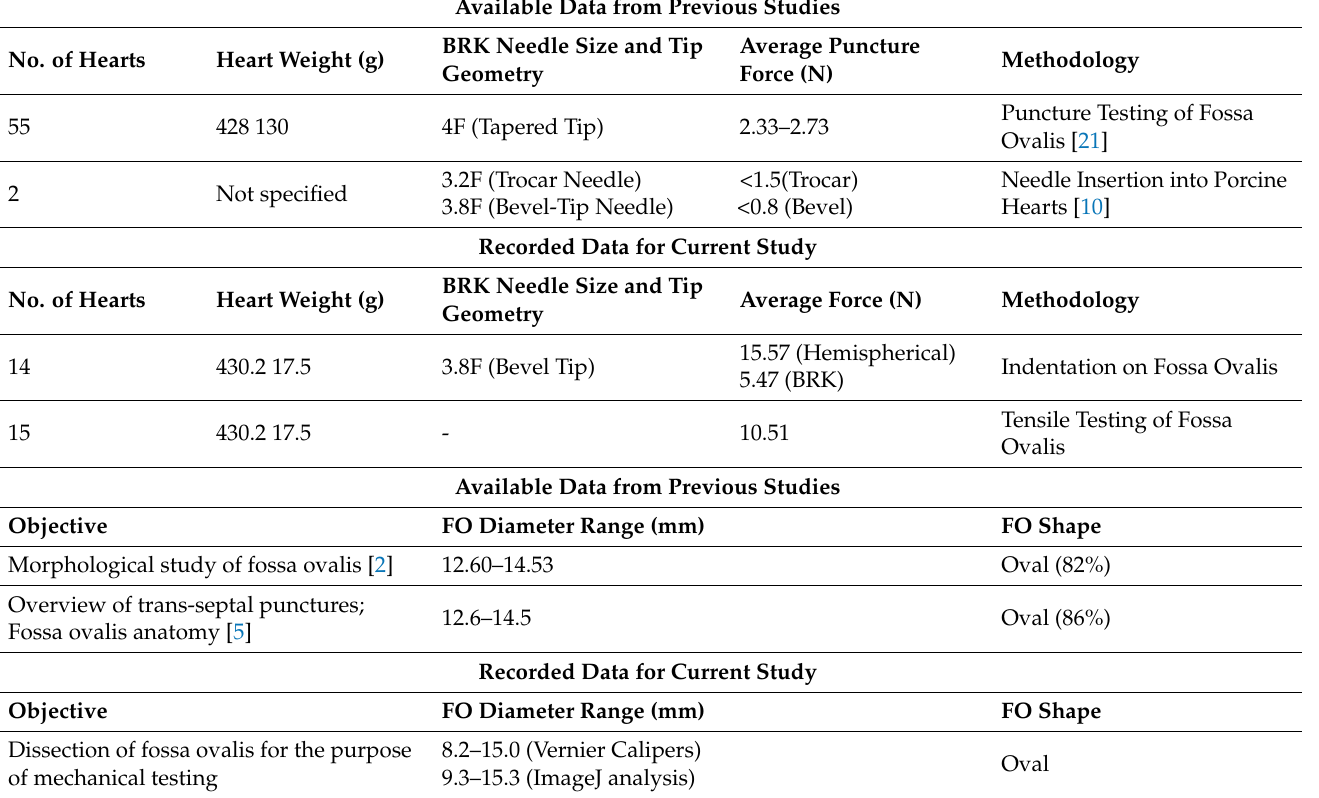
Table 1. Diameter data